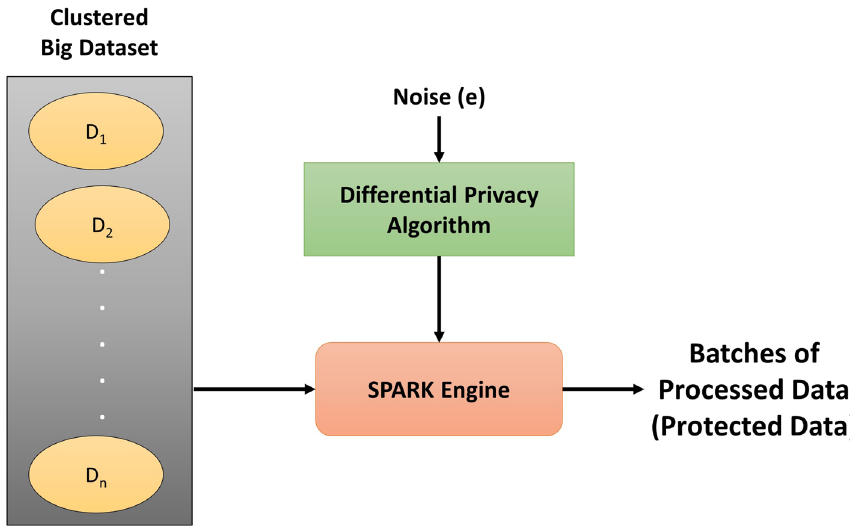
Fig. 6 Step 5 of proposed